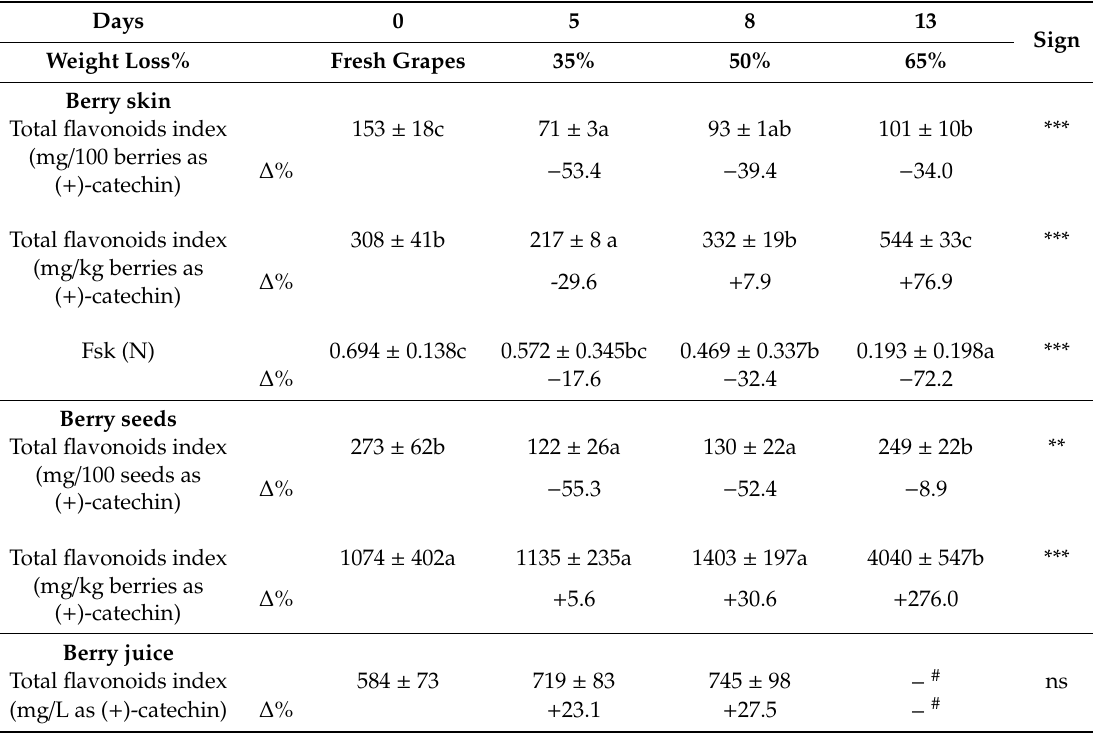
Table 6. Evolution of skin hardness and polyphenols in the berry skin, seeds, and juice obtained from the pulp of Muscat of Alexandria grapes during